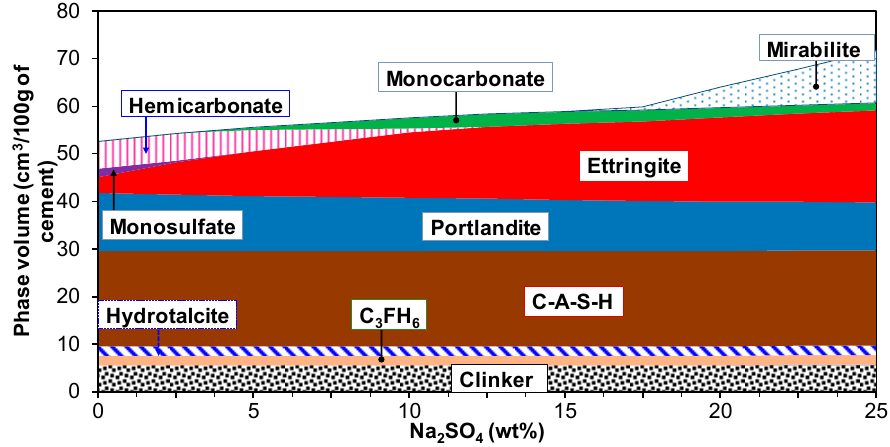
Figure 7. Distribution of hydrates at 28 days of hydration of PC as a function of Na 2 SO 4 addition.